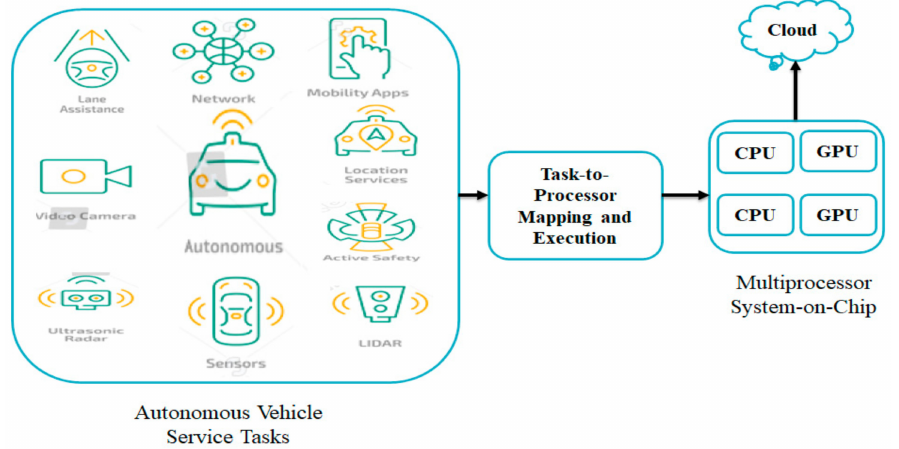
Figure 1. The building block of the proposed Intelligent Mapping